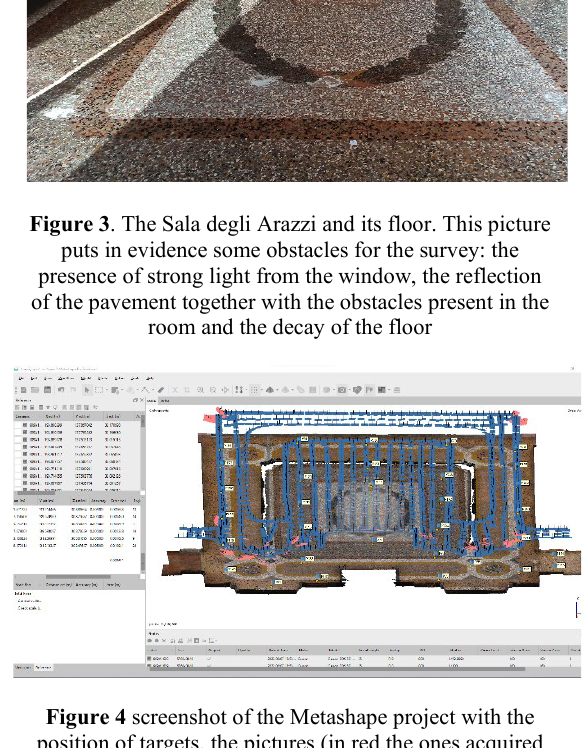
Figure 4 screenshot of the Metashape project with the position of targets, the pictures (in red the ones acquired manually) and the dense